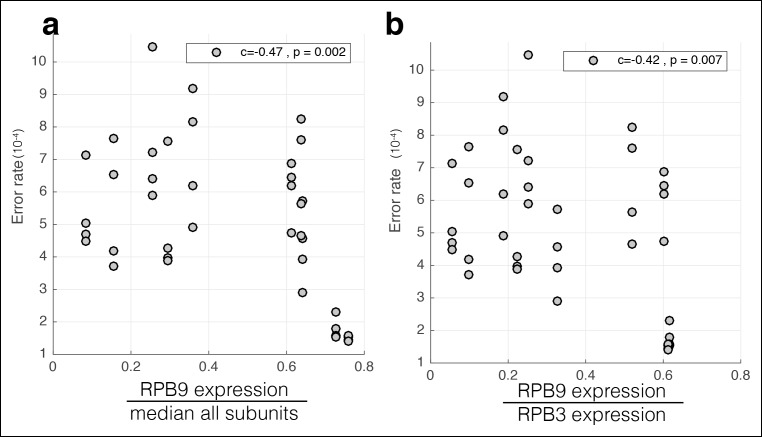
RBP9 expression negatively correlates with RNA-seq mismatch rates.The mismatch frequency is shown across all cells lines. (a) RPB9 mRNA expression is normalized by the median expression level of all subunits. (b) RPB9 mRNA expression is normalized by RBP3 (POLR2C) expression.